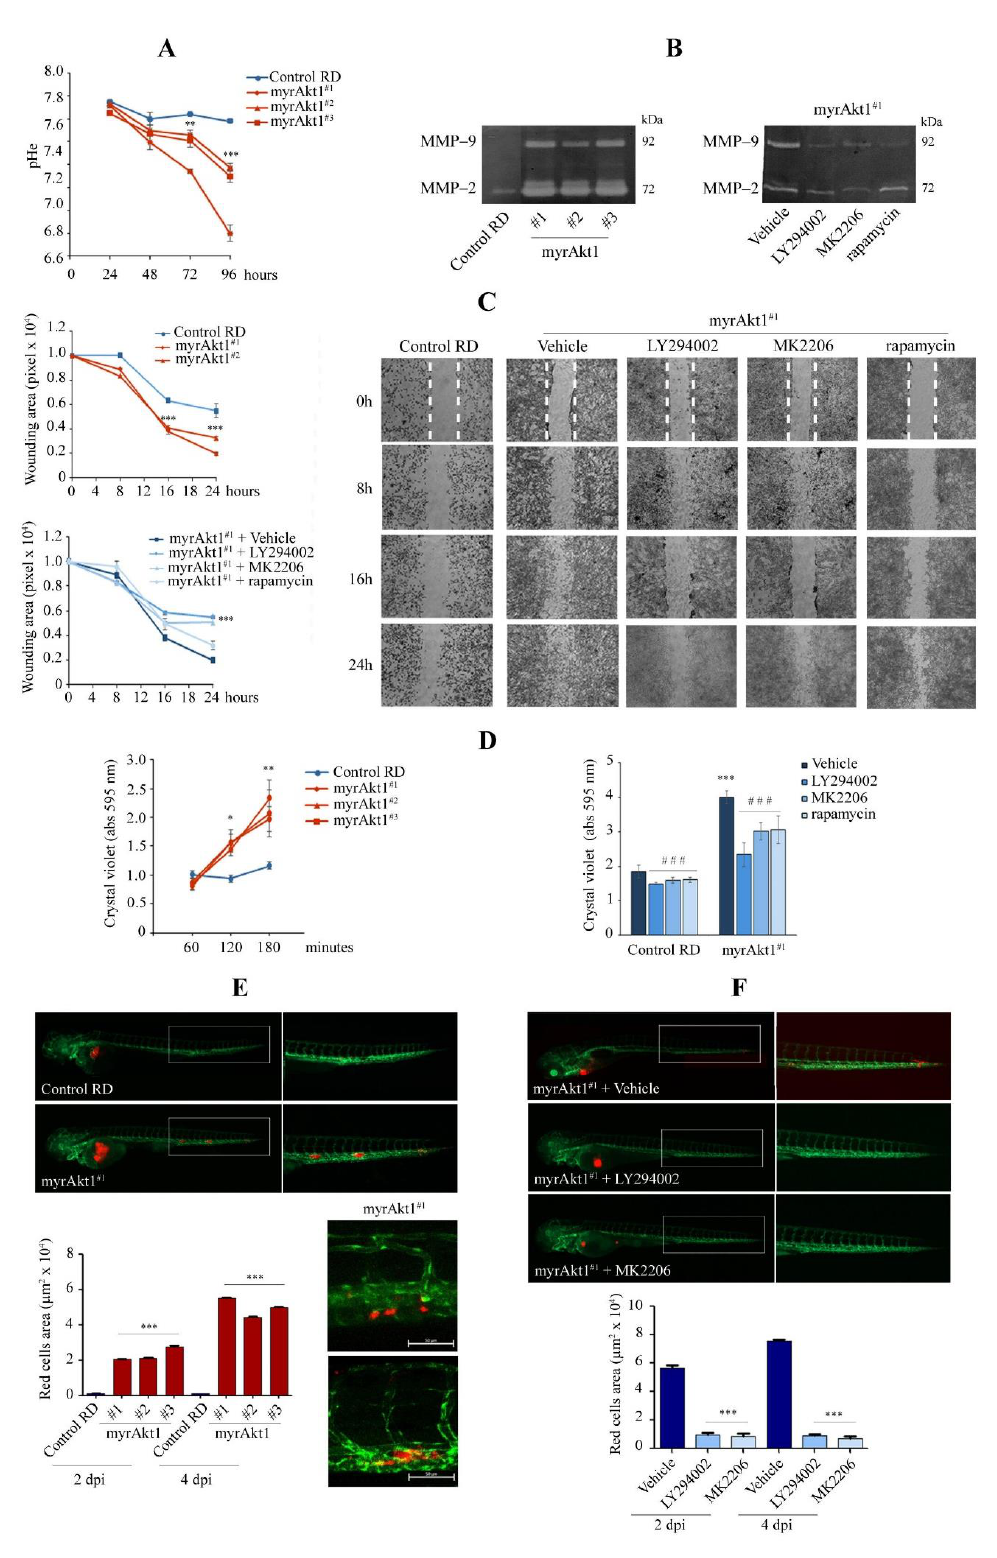
Figure 2. Analysis of cell invasion and migration by in vitro and in vivo assays. ( A ) Control and myrAkt1 cells (6 × 10 4 ) were seeded into 6-multiwell plates and left to proliferate up to 96 h. At